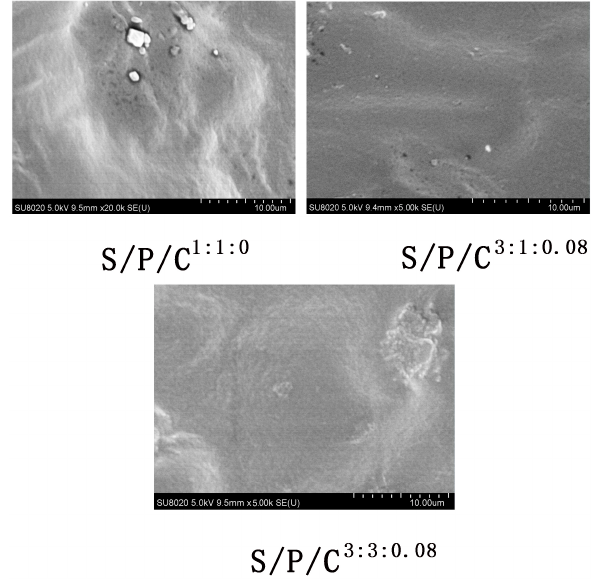
Figure 1. FE-SEM images of starch/polyvinyl alcohol/citric acid ternary blend functional food packaging films.